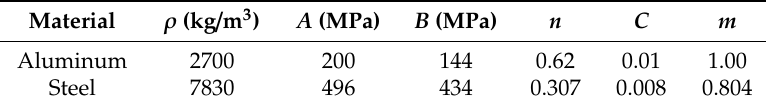
Table 5. Material parameters of aluminum and steel.